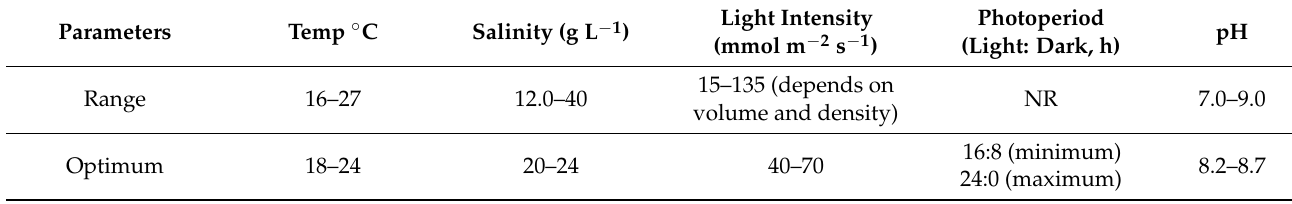
Table 2. General factors for the cultivation of microalgae.